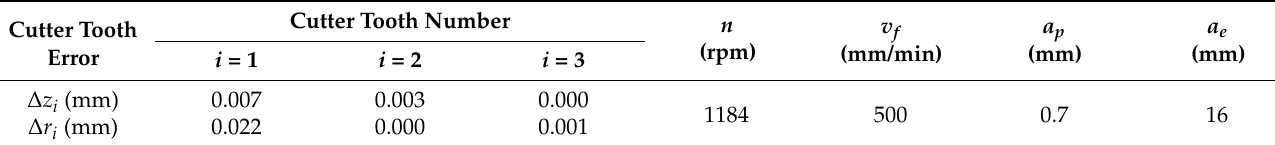
Table 3. Milling experiment, scheme